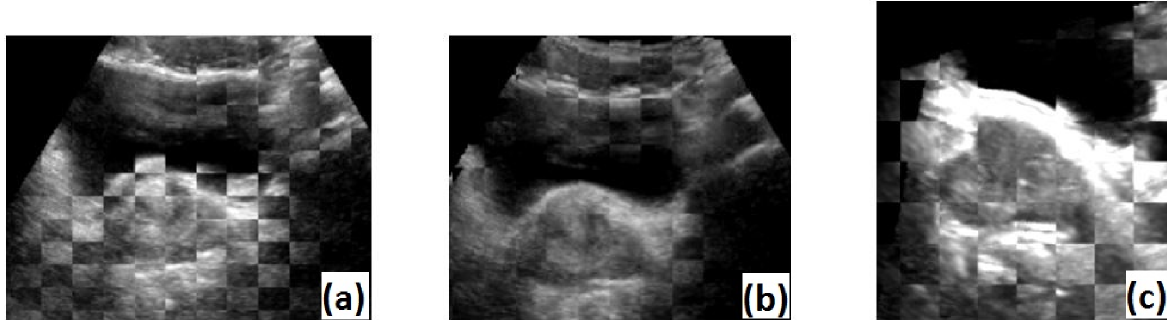
is the rigid US ! US